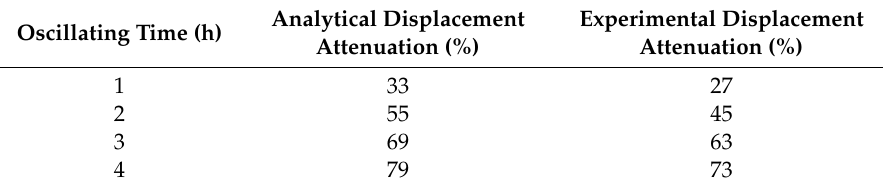
Table 2. Comparison between analytical and experimental results.